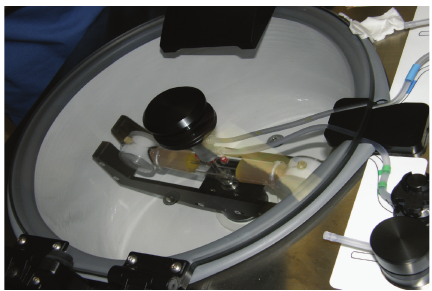
Figure 2: The Adipose-derived stem cells are processed in a closed- circuit machine within 1.5